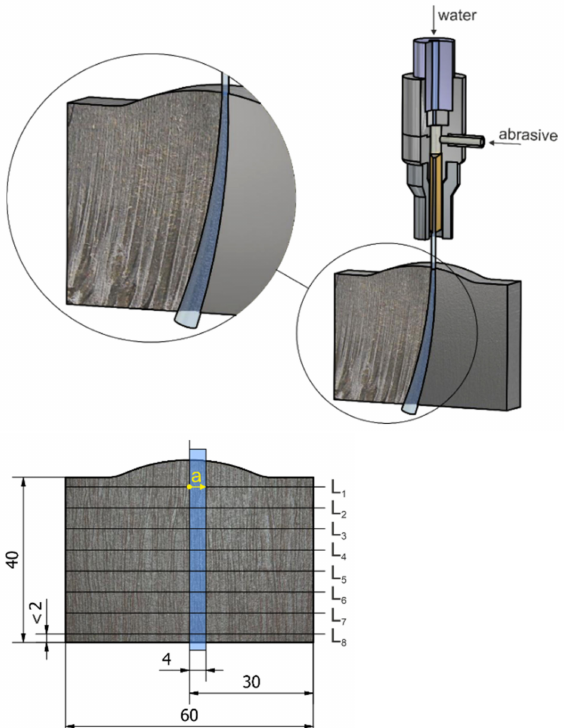
Figure 4. Measurement principle, displayed lines from L1 to L8, direction of travel of the roughness measuring probe (measured length l r = 4 mm, direction of tip movement—in the direction of the arrow “a”), and the actual surface after the AWJ machining (sample 1, set